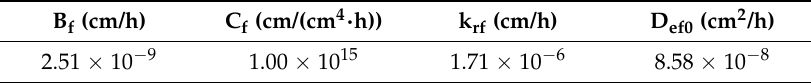
Table 2. The parameters in the hydration model of fly ash.